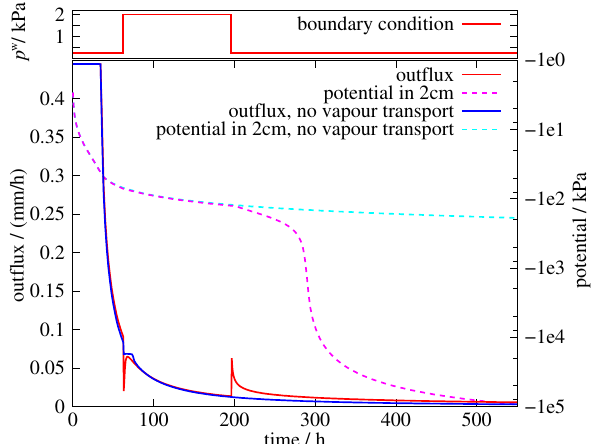
Fig. 8. Influence of water vapour transport on the results: The three- step experiment was simulated taking vapour transport inside the soil into account (the normal case, red) and without considering it (blue). Notice that p w jumps from equilibrium to 0.25kPa at t = 0. For more explanations see Sect. 3.2.1.